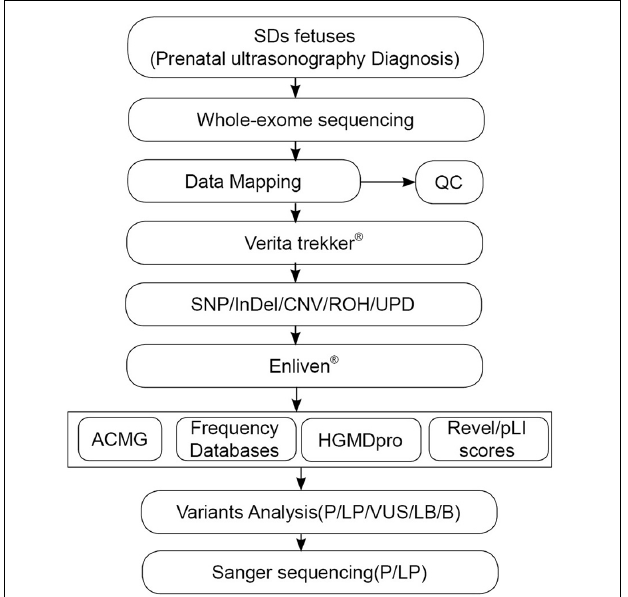
FIGURE 1 | The overall experimental workflow in the present study. ACMG, American College of Medical Genetics and Genomics; Verita trekker R (cid:13) and Enliven R (cid:13) represent patented software of Berry Genomics; CNV, copy number variation; HGMD, Human Gene Mutation Database; InDel, insertion/deletion; Mt, mitochondrial variation; QC, quality control; ROH, runs of homozygosity; SNP, single nucleotide polymorphism; WES, whole–exome